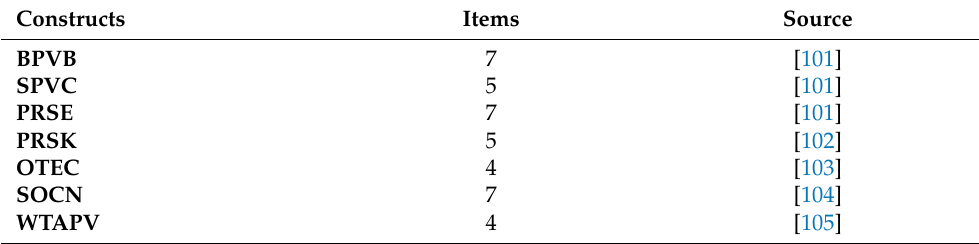
Table 3. Measurement